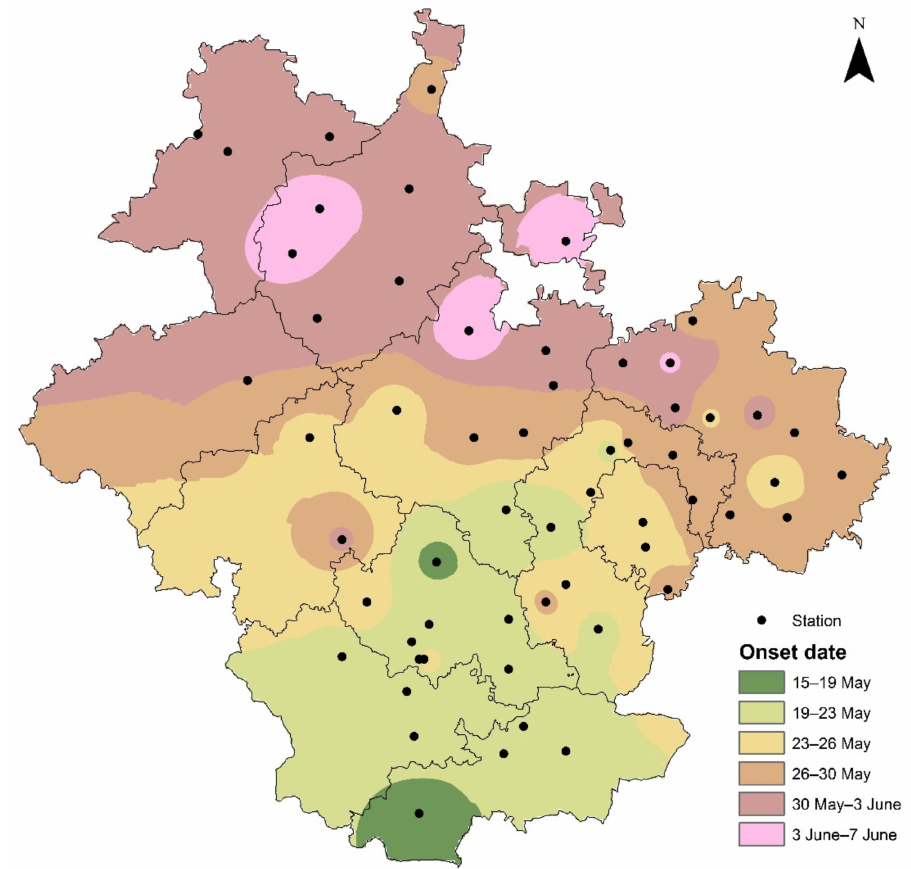
Figure 5. The variability of agro-climatic onset of monsoon over the study